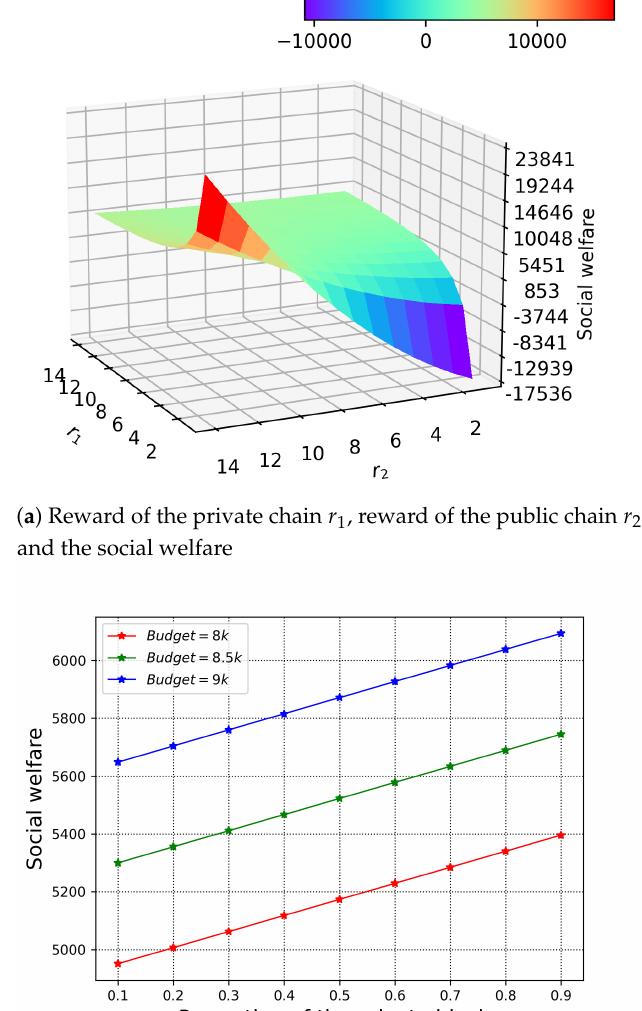
Figure 7. Social welfare and